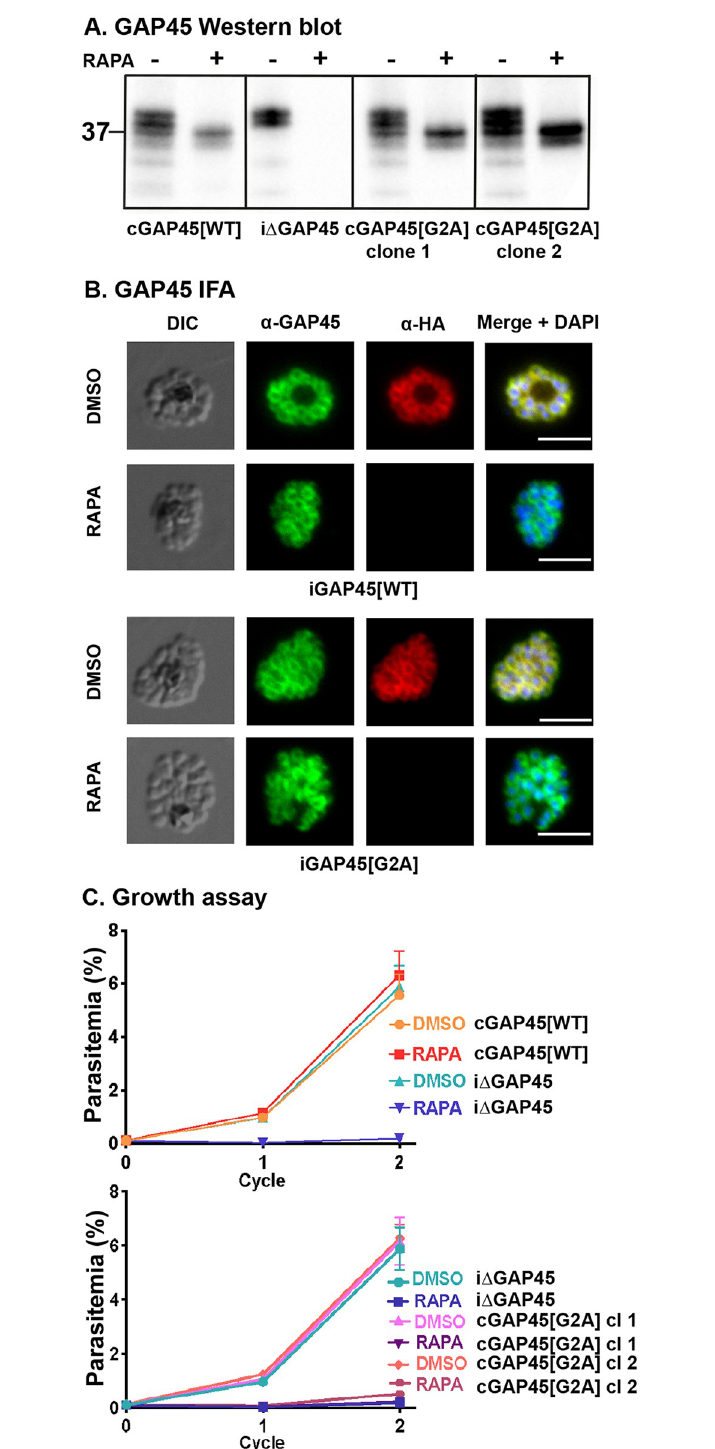
Fig 5. GAP45[G2A] is at the same subcellular location as GAP45, but the parasite has a growth defect. (A) Western blots showing successful rapamycin-inducible ablation of gap45 : ha3 : loxP expression (i Δ GAP45), but expression of WT (cGAP45[WT]) and G2A (cGAP45[G2A]) from the Pfs47 site is unaffected. Note that HA3-tagged GAP45 adds additional mass to the protein resulting in a lower mobility in the gel. After rapamycin treatment, in GAP45[WT] and both GAP45[G2A] parasite clones the endogenous GAP45-HA3 is deleted but the second copy of the gene is still expressed (experiment performed in duplicate with 2 independent clones). Mobility of a molecular mass